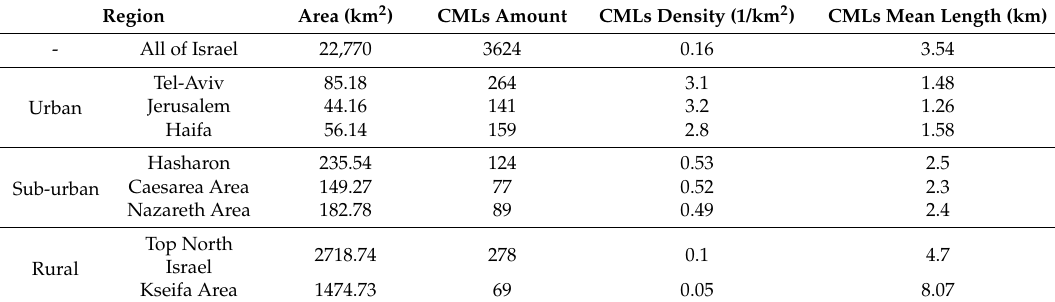
Table 2. Empirical CML distributions based on environment type. Sub-regions are described in the appendix. Note that region “Tel Aviv”, for instance, does not apply solely to the city of Tel Aviv but to a more general region [13].